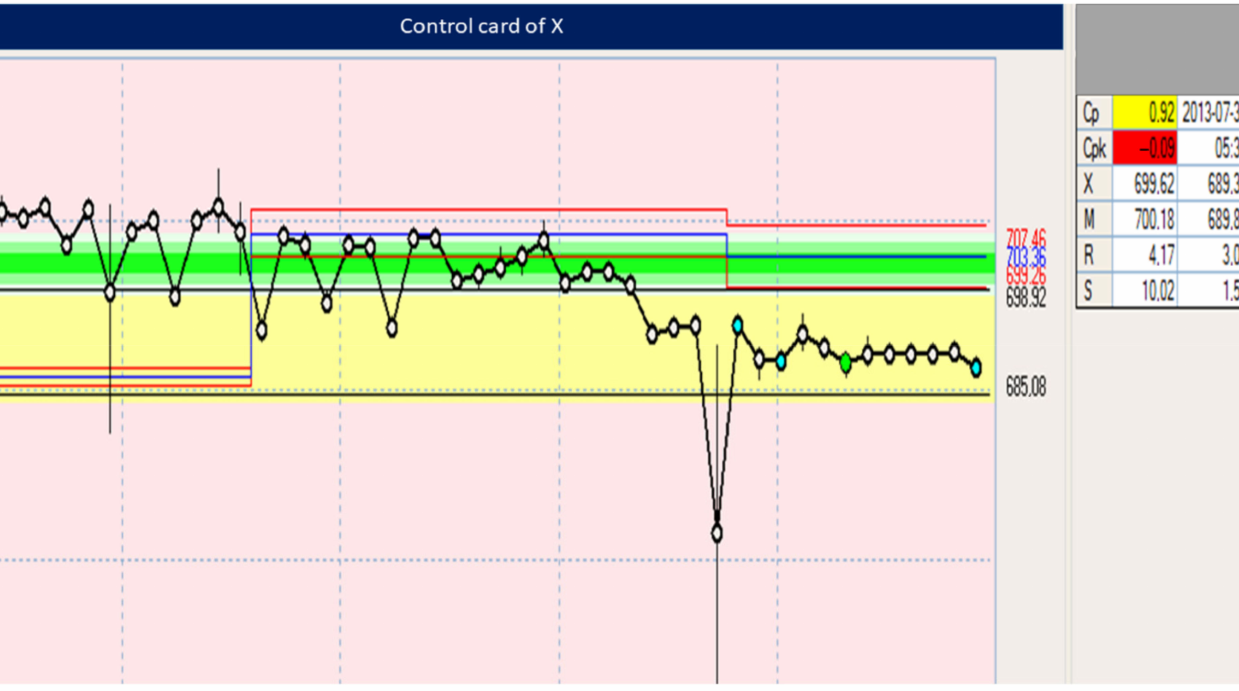
Figure 25. Image showing the onset of injection